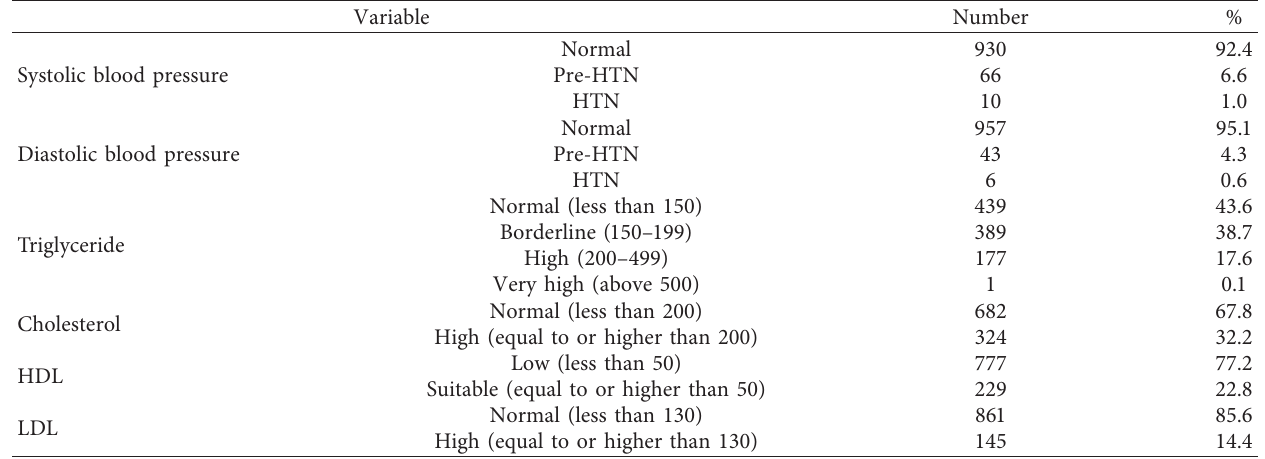
Table 2: Frequency distribution of clinical laboratory variables.